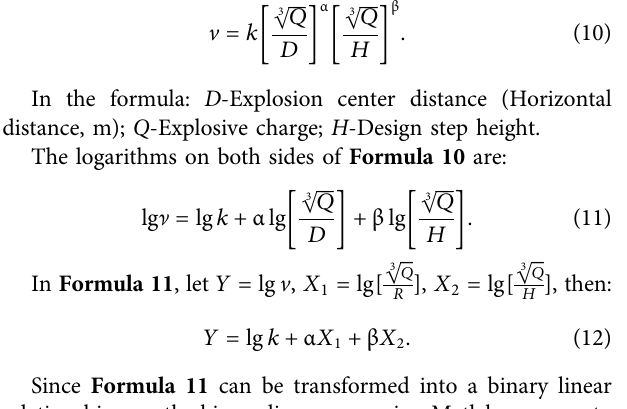
Figure 11B , the calculation can be: k (cid:2) 19.3108, a (cid:2) 0.8960, ß (cid:2) 0.0350.